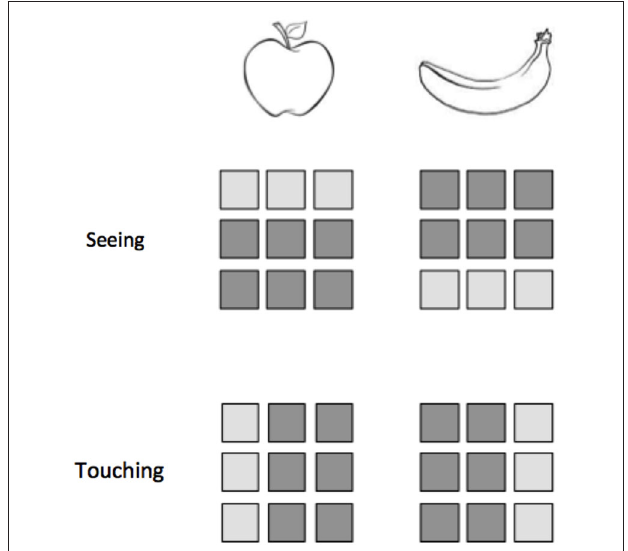
FIGURE 2 | Classification within modalities does not ensure the success of classification across modalities . Consider an experiment in which participants either see or touch two objects, an apple and a banana. Here we represent a hypothetical 9-voxel pattern of activity for each stimulus presentation. While the patterns for apple and banana are distinguishable within vision and within touch, a classifier trained on one modality would not be able to correctly identify the patterns from the other